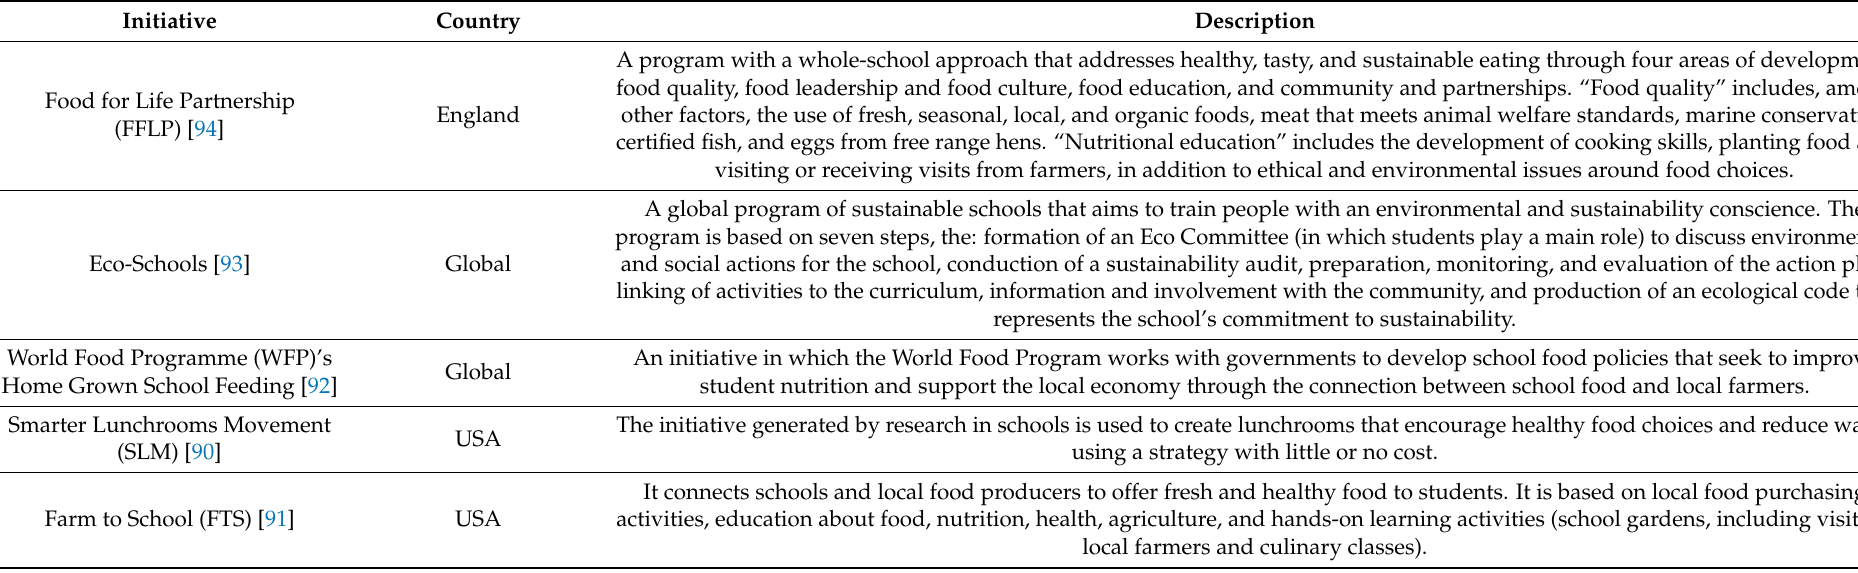
Table 3. Other available non-governmental school feeding programs/initiatives retrieved from the